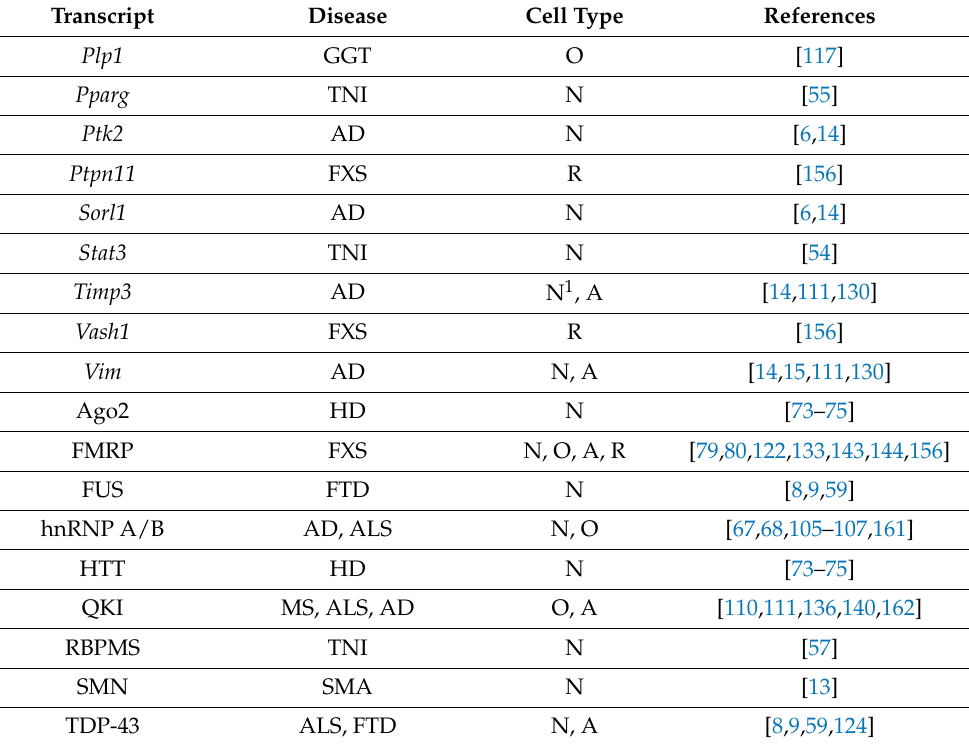
Table 2. Cont . List of mRNAs/microRNAs Localized to Subcellular Compartments in Neurons and Glia and Implicated in Diseases Transcript